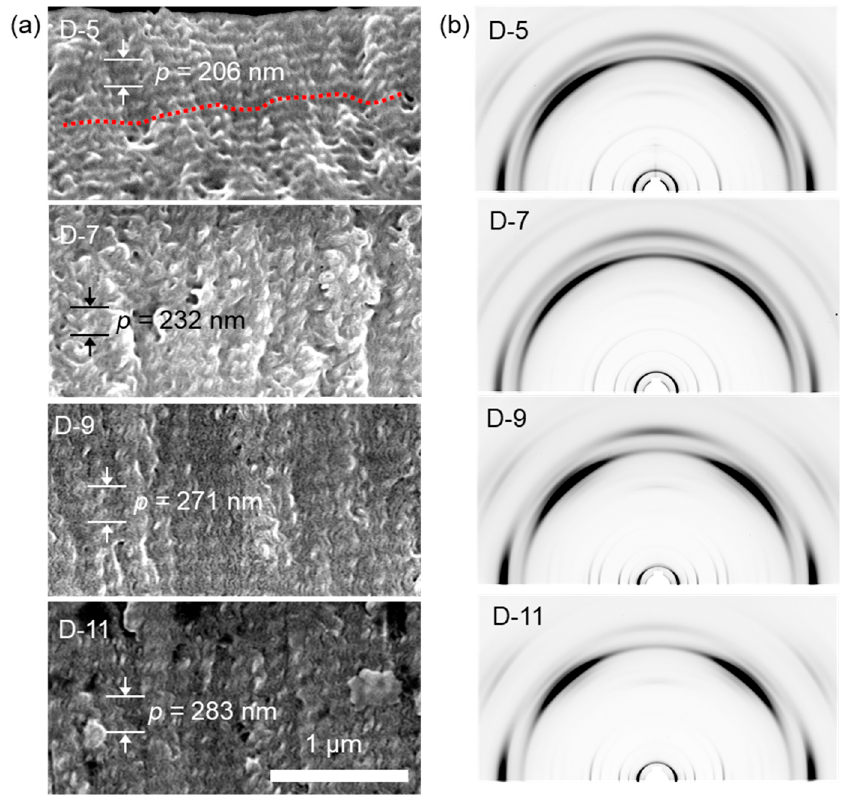
Figure 10. ( a ) Cross-sectional SEM images and ( b ) 2D-GIXD results of UV-treated D-n homologues in their HNF phase. Reprinted with permission from [7], Copyright 2019, Springer Nature.